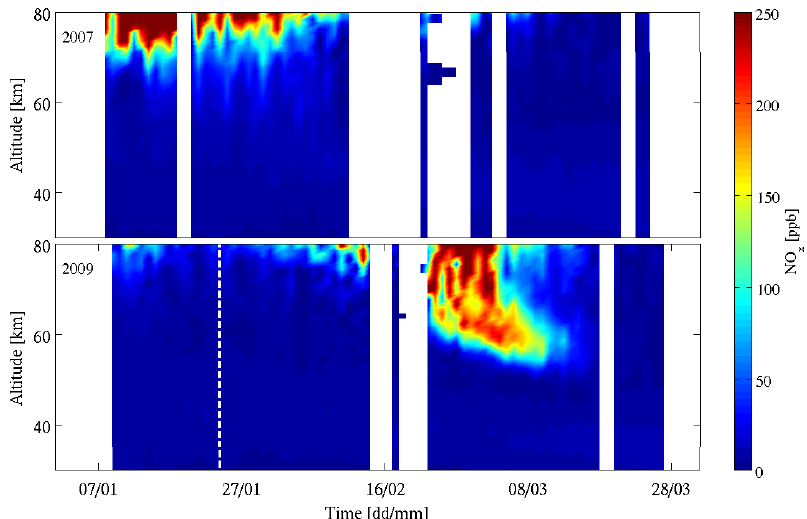
Fig. 4. NO x time series (ppb) as daily medians measured by ACE-FTS. White dashed line indicates the time point, when the criteria for the major SSW were fulfilled in 2009. The upper panel is for 2007 and the lower for 2009. White regions indicate missing data or not enough data.